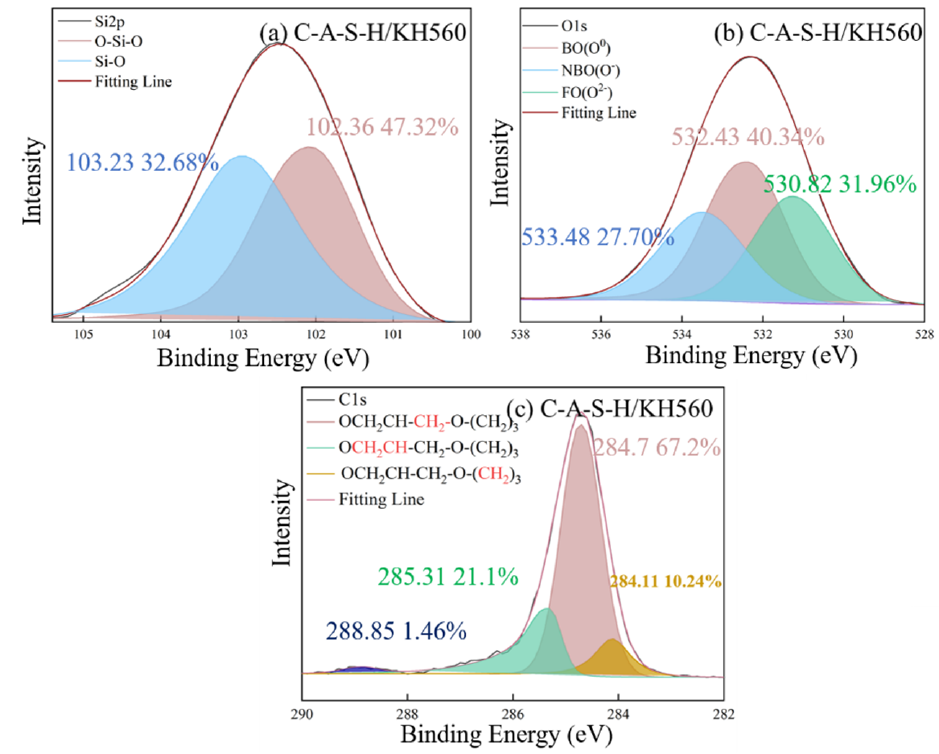
Figure 14. The XPS deconvolution spectrum of ( a ) Si 2p, ( b ) O1s, ( c ) Ca 2p/3 of C ‐ A ‐ S ‐ H/KH560.